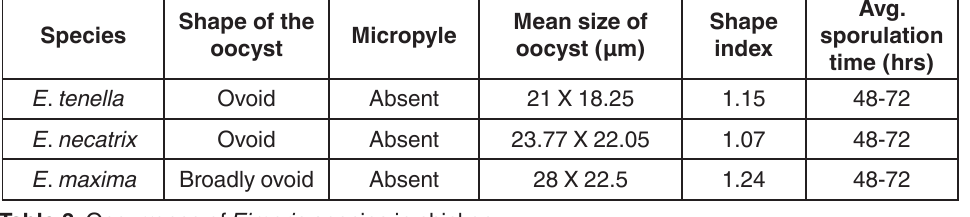
Table 3. Occurrence of Eimeria species in chicken species